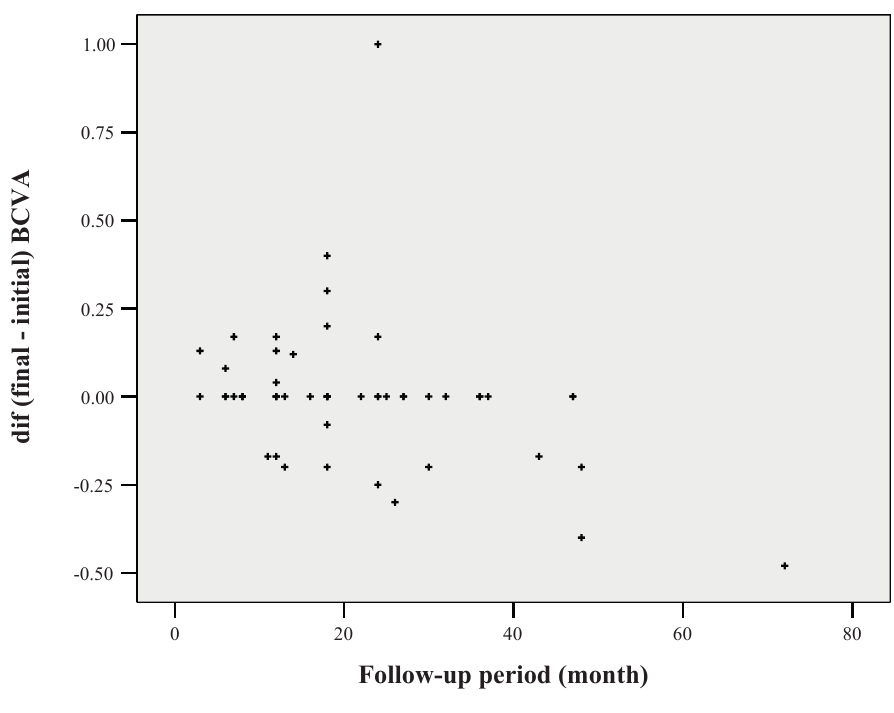
Fig. 7. Dependence of changes in BCVA (difference between the final and initial BCVA) during the follow-up, Spearman = -0.351, P =